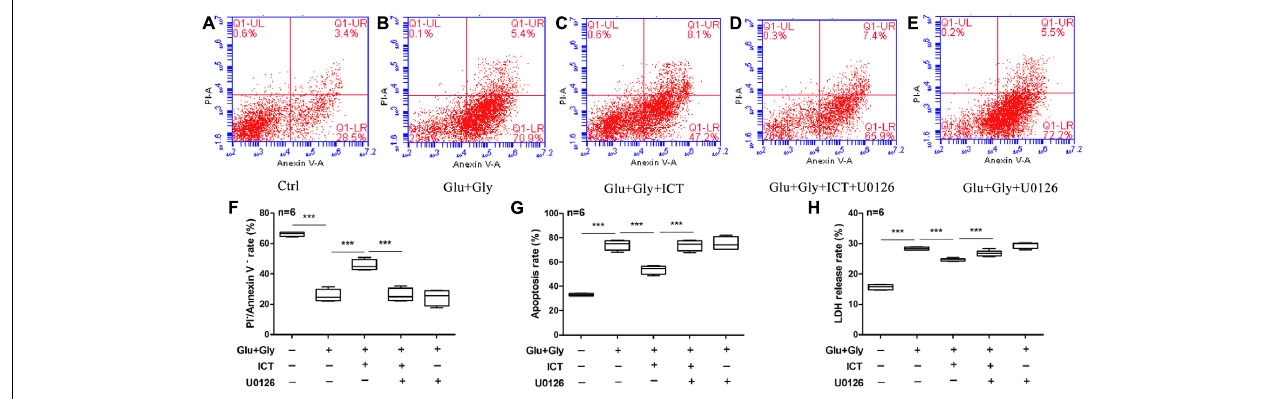
FIGURE 6 | The inhibition of ERK blocks the anti-apoptotic ability of ICT in glutamate-induced neuronal injury. The annexin V/PI double staining data collected by flow cytometry are shown in scatter plots (A–E) . The percentage of surviving (F) and apoptotic (G) neurons and LDH release rate (H) from the five treatment groups